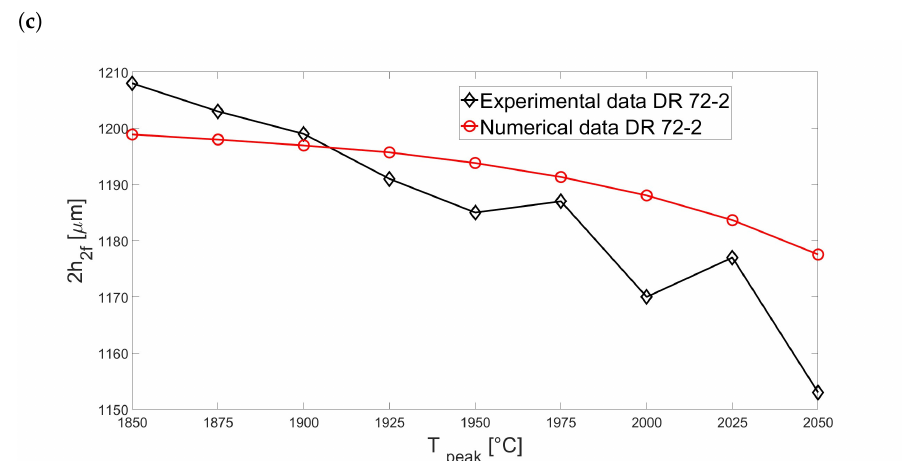
Figure 5. Comparison between the final external diameter of the capillary obtained numerically and experimentally by Luzi et al. [20] for the three different drawing ratios ( a ) DR36-1, ( b ) 54-15, and ( c ) 72-2 at different furnace peak temperatures.